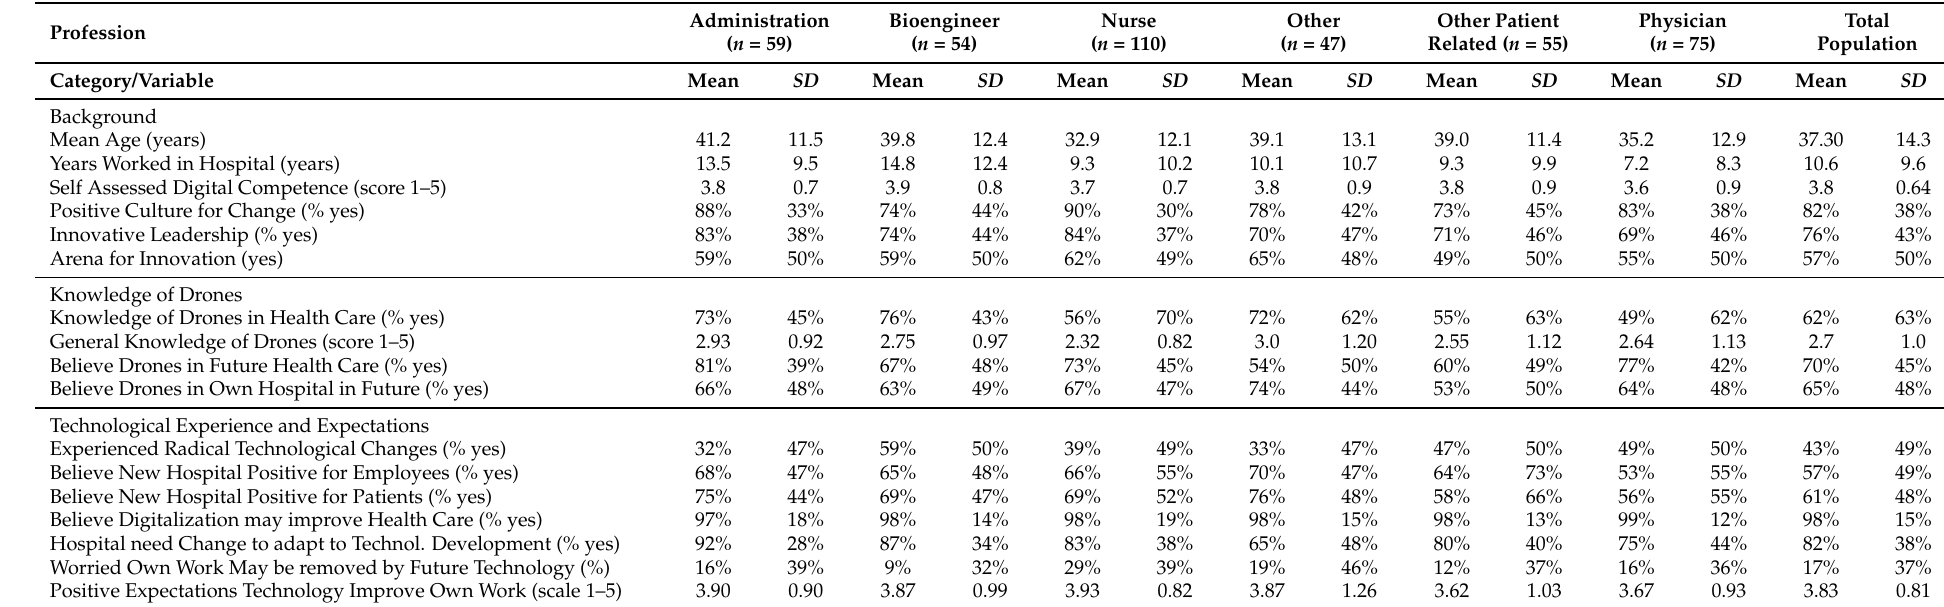
Table 1. Summary of data by personnel